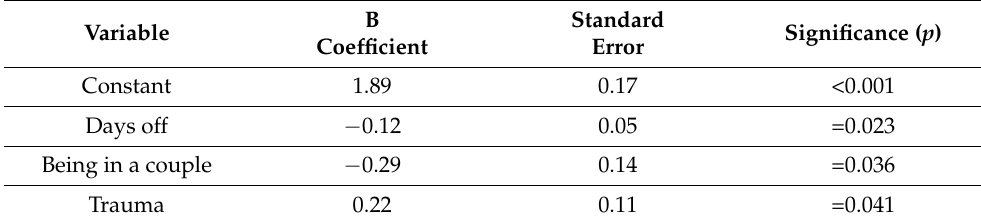
Table 3. The backward selection type of multiple logistic regression with predictive factors for burnout (R Square = 0.22).